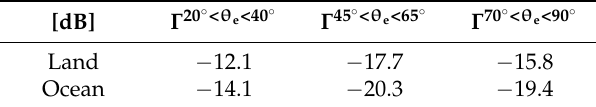
Table 1. Summary of the impact of the elevation angle θ e on Γ LHCP,CyGNSS over land and